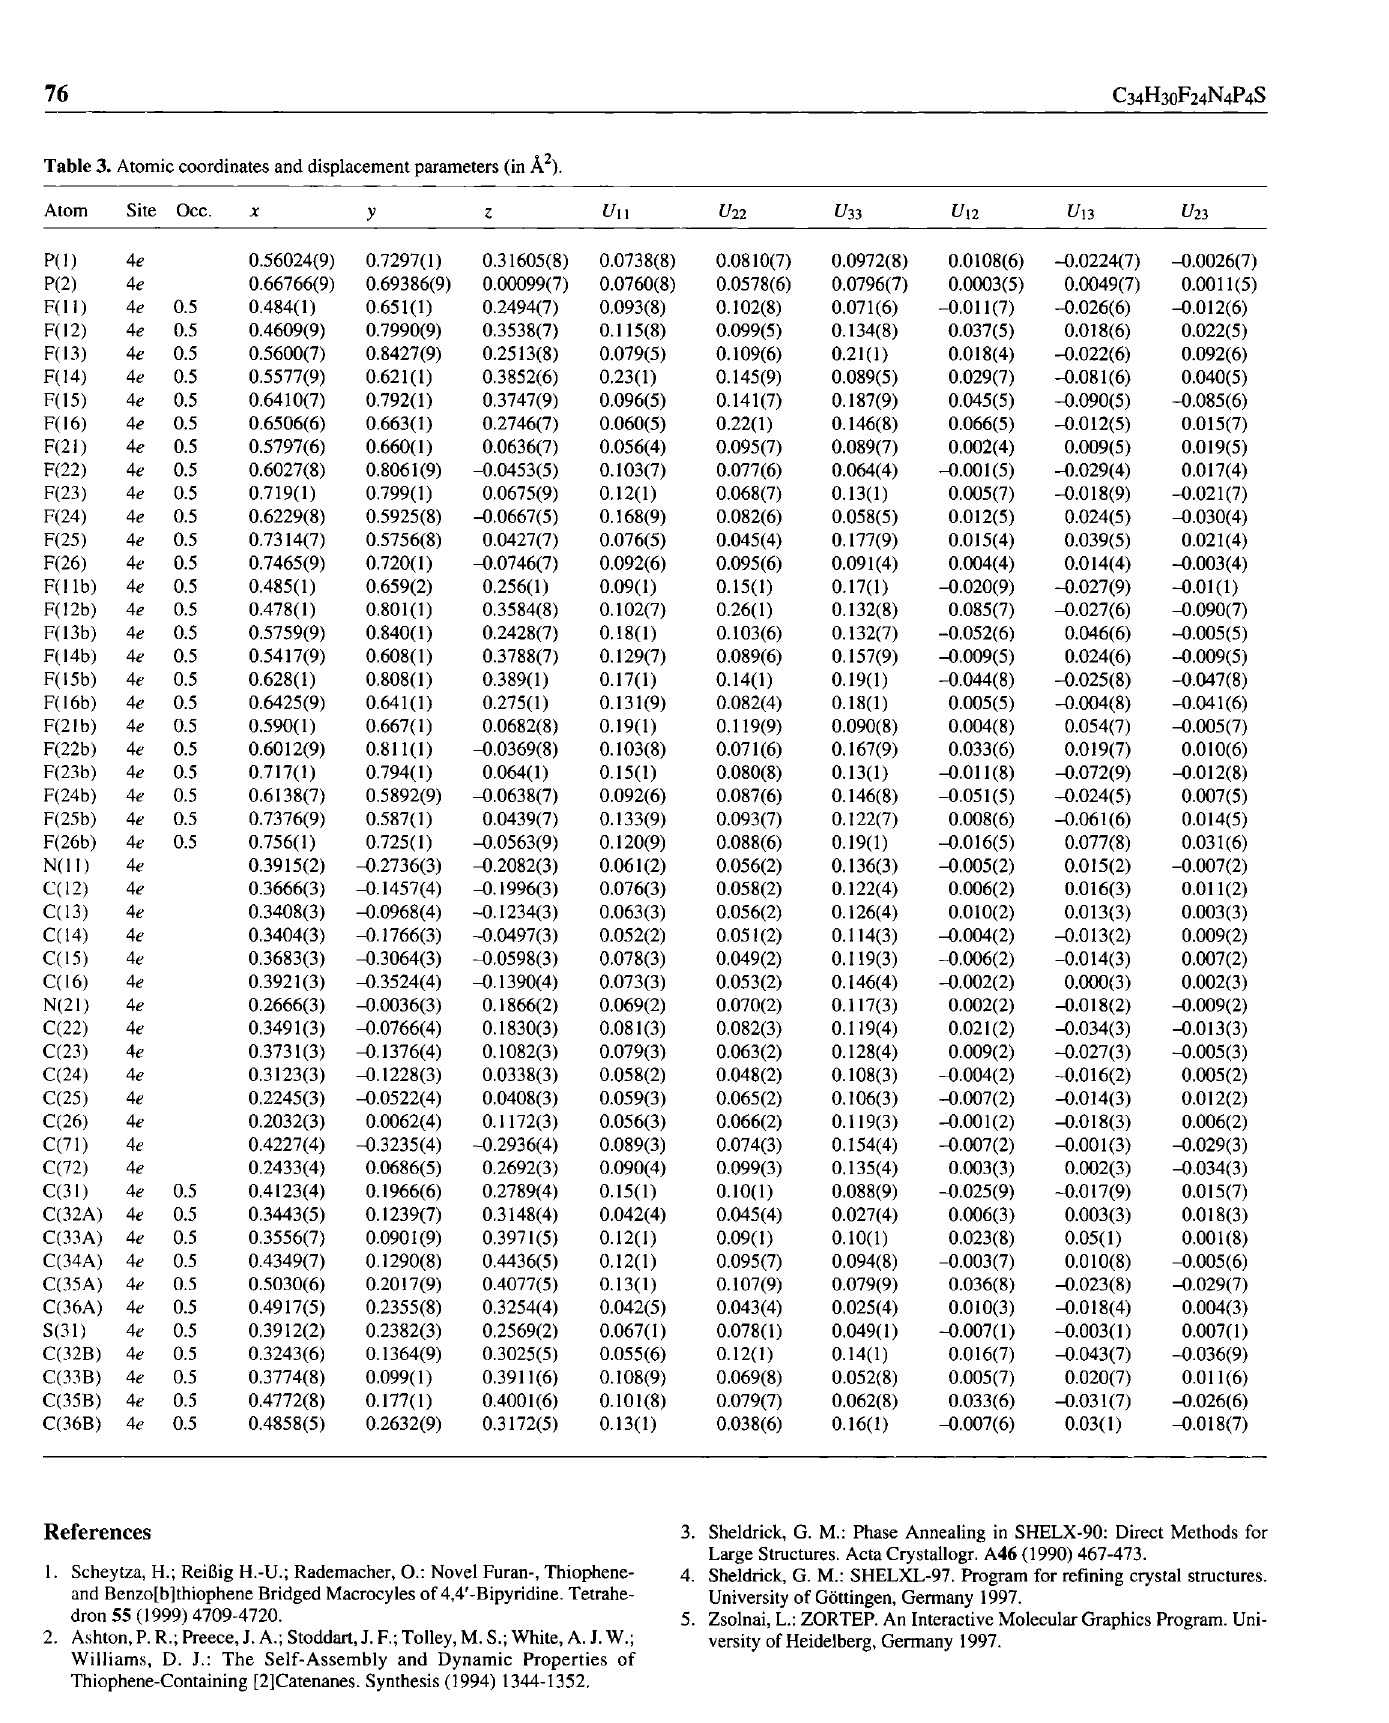
Table 3. Atomic coordinates and displacement parameters (in Ä 2